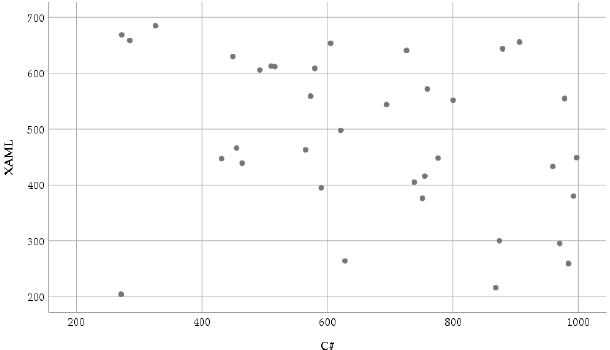
Figure 9. Scatter plot of the number of fixations (count) based on XAML and classic C#. The normality results of the average fixation number measured in the XAML code are significant (XAML: W (36) = 0.935, p = 0.035, C#: W (36) = 0.951, p = 0.109). Due to the results of the normality test, the Wilcoxon signed-rank test was used: ( T = 526, Z = 3.032, p = 0.002 (2-tailed), r = 0.357). Regarding the obtained results, it can be stated that the average fixation number was significantly less with a medium effect in the case of the XAML: Mdn = 482 than in the case of the C#: Mdn = 661. The distribution of the average fixation number based on XAML, and classic C# is shown in Figure 10.